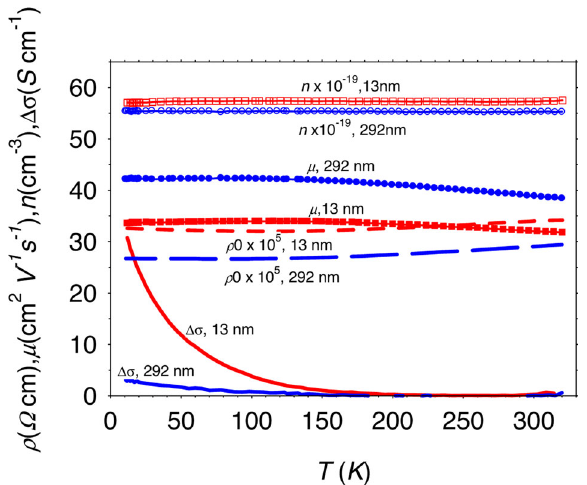
Fig. 3 Temperature dependence of resistivity, volume concentration, mobility, and magnetoconductivity. Carrier concentration n: open red squares, 13 nm sample; open blue circles, 292 nm sample. Mobility μ : closed red squares, 13 nm; closed blue circles, 292 nm. Resistivity, ρ 0: dashed red line, 13 nm; dashed blue line, 292 nm. Magnetoconductivity Δ σ : red solid line, 13 nm; blue solid line, 292 nm. At low temperatures, Δ σ has by far a stronger thickness dependence than that of n , μ , and ρ 0.